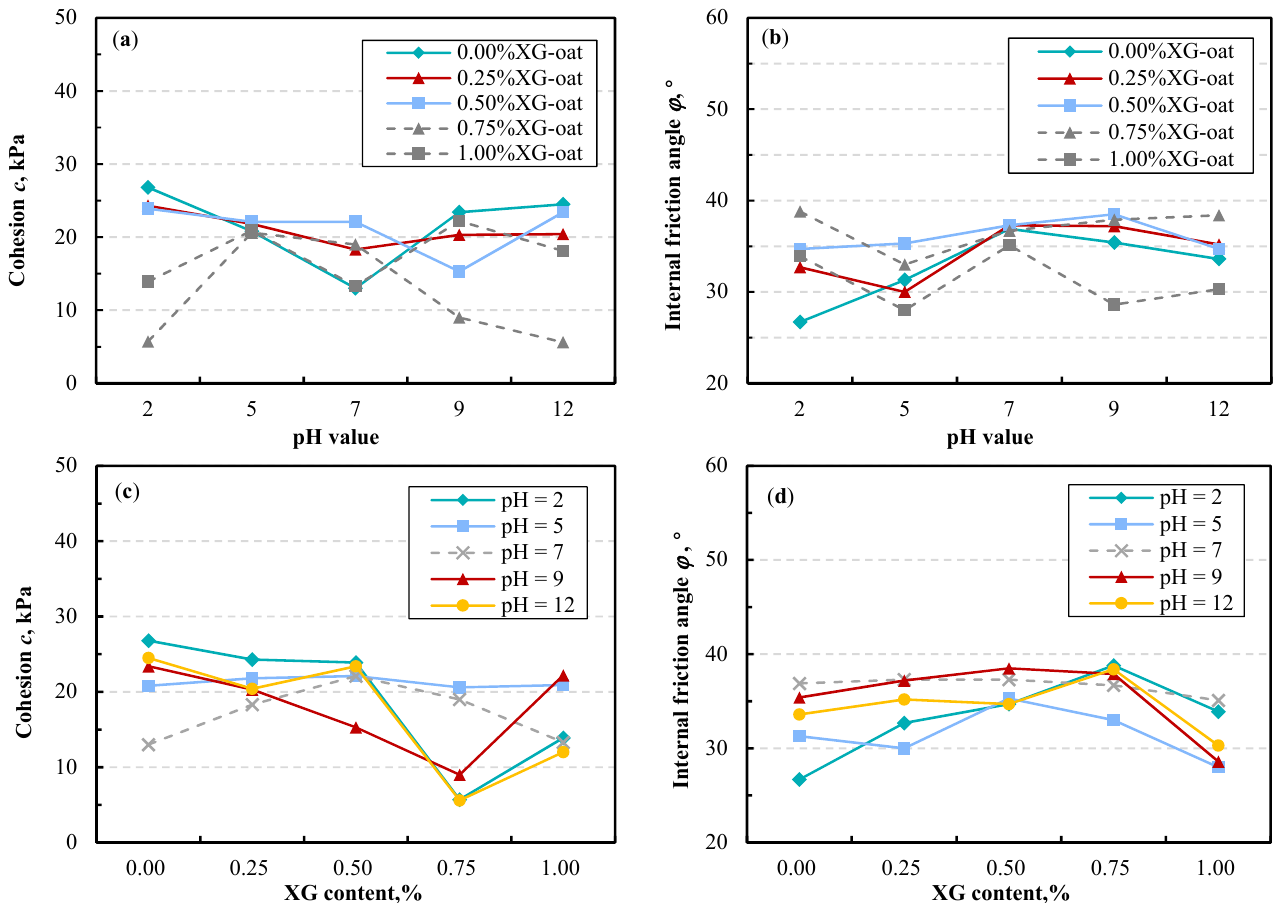
Figure 15. ( a ) Cohesion versus pH value; ( b ) internal friction angle versus pH value; ( c ) cohesion versus XG content; ( d ) internal friction angle versus XG content.